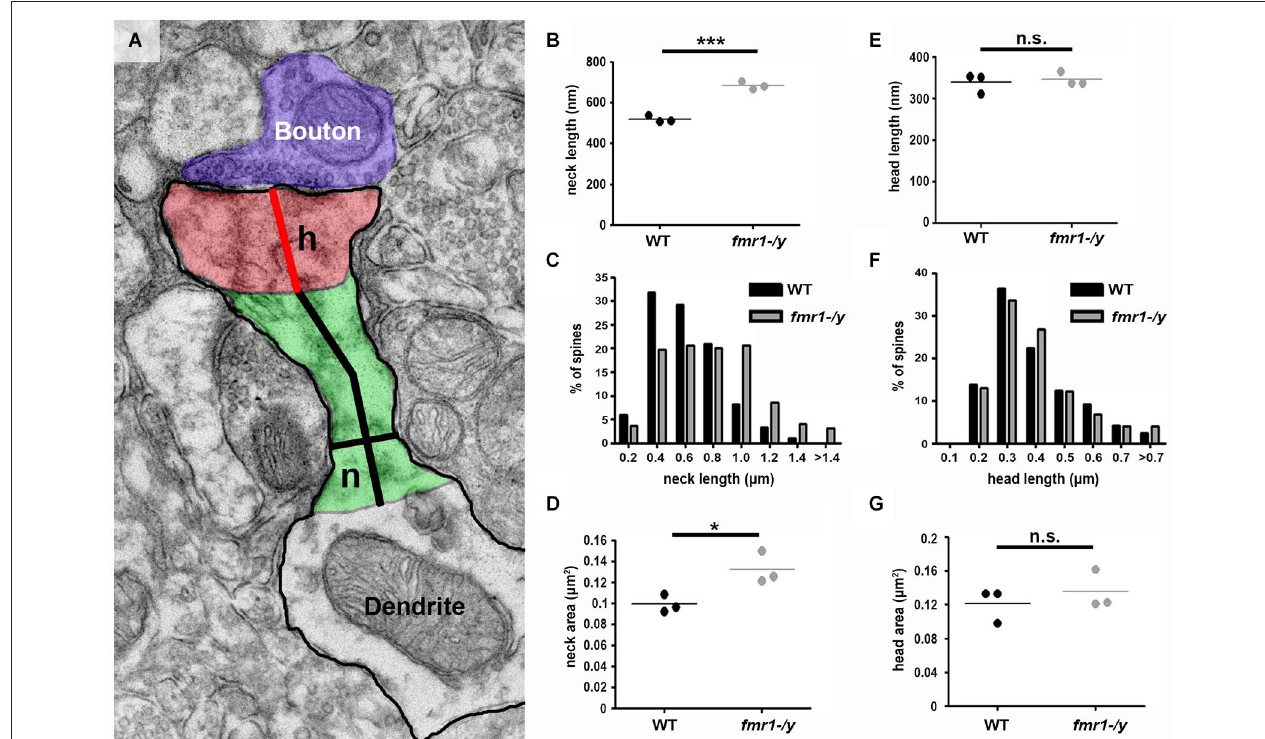
genotype reveals a higher incidence of longer necks in the fmr1-/y mice compared to wild-type. Chi-squared test, p < 0.0001. (D) The area of fmr1-/y spine necks was significantly larger than those of wild-type spines. Unpaired t -test, p = 0.031. In striking contrast to the changes in fmr1-/y spine necks, the spine heads were not different in length (E) ; unpaired t -test p = 0.684. (F) ; chi-squared test p = 0.795) or in area (G) ; unpaired t -test p =